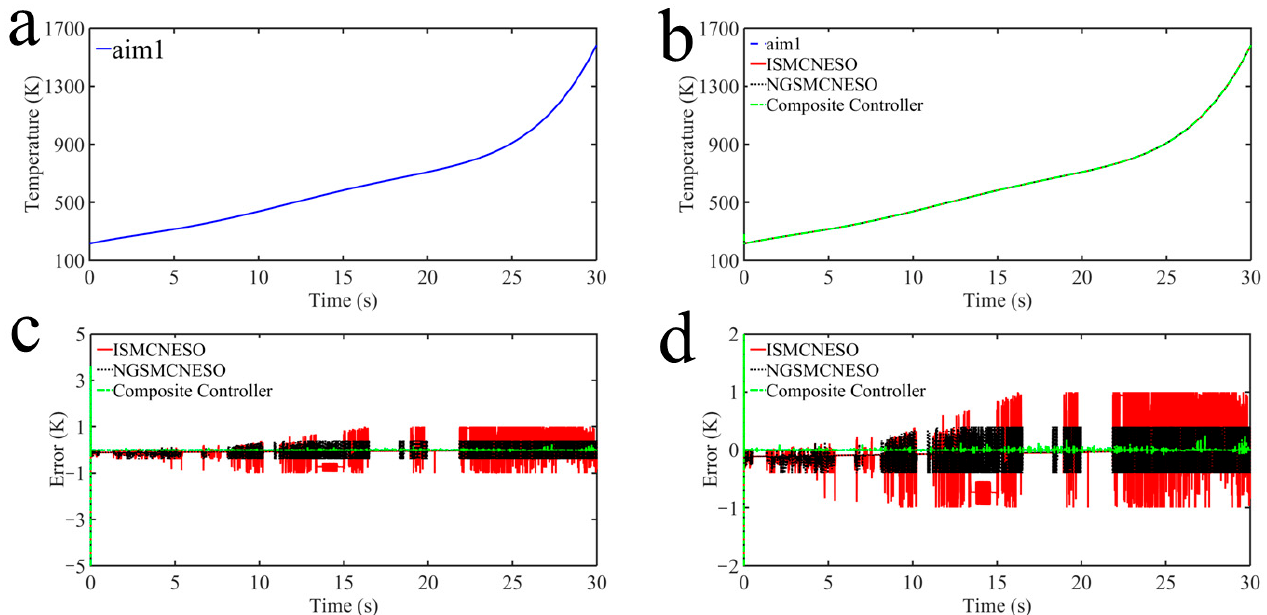
Figure 14. Simulation results: ( a ) the fitting curve of the reference temperature trajectory from Wall 0_0 mm; ( b ) the reference temperature tracking performance among ISMCNESO controller, NGSMCNESO controller, composite controller; ( c ) the tracking errors; ( d ) their partial enlarged figures in details.